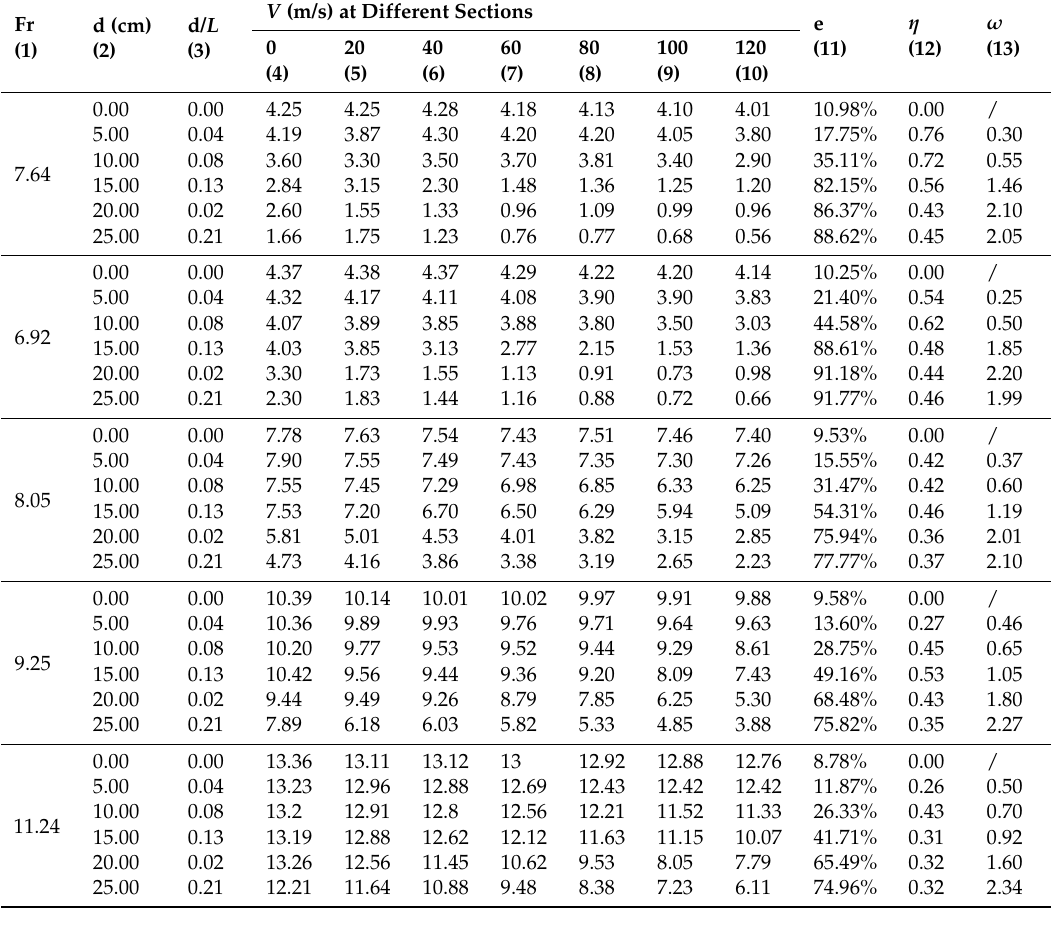
Table 3. The unit volume energy dissipation rate of the stilling